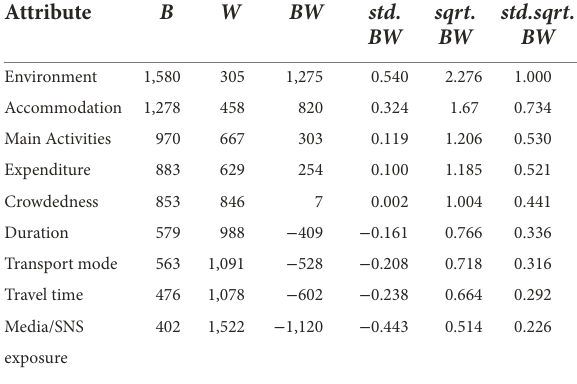
TABLE 3 Aggregated best-worst